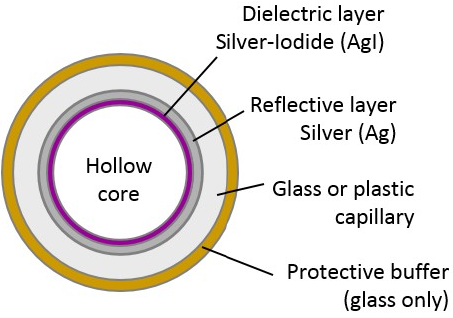
Figure 1. Basic diagram of a hollow-core fiber cell internal structure. Source: guidingphotonics.com (accessed on 20 November 2021) [24].